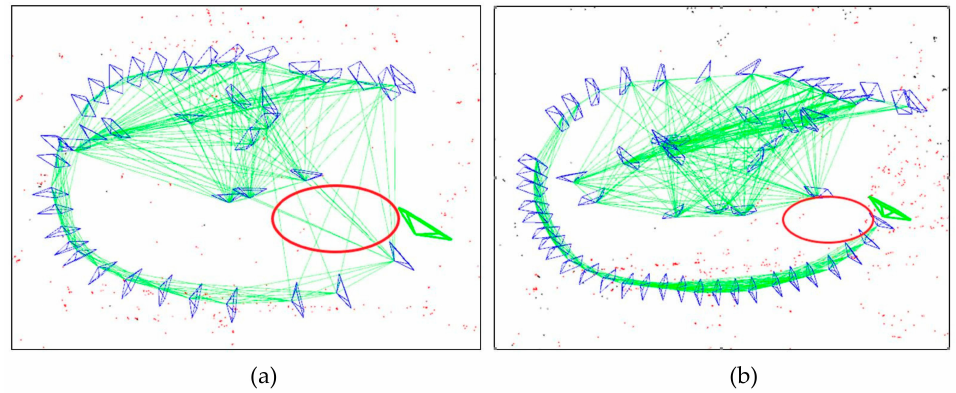
Figure8. Intheredcircle, thegreenlinesrepresenttheconstraintsbetweenkeyframes(blue). Oursystem has more lines than the normal ORB-SLAM. ( a ) The omnidirectional ORB-SLAM; ( b ) The normal ORB-SLAM. (Dataset: